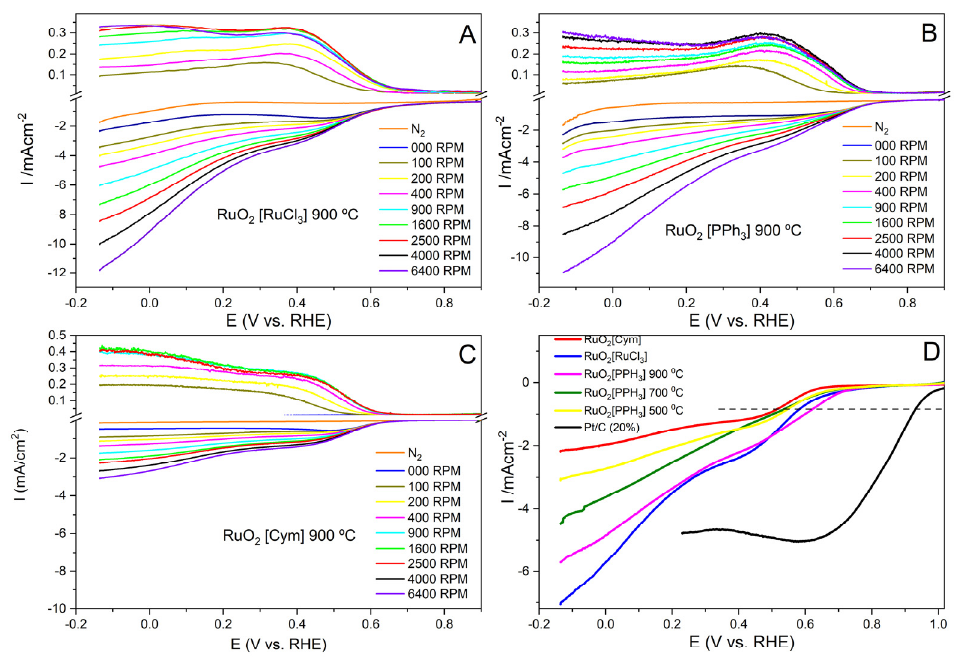
Figure 6. LSV curves of the explored materials: ( A ) RuO 2 [Cym], ( B ) RuO 2 [RuCl 3 ], and ( C ) RuO 2 [PPh 3 ] calcined at 900 °C, respectively, obtained using an RRDE in O 2 and N 2 − saturated 0.1 KOH. Rotation rate values are included in each graph. ( D ) ORR LSV curves of the different materials at 1600 rpm compared with Pt/C (20%) curve.